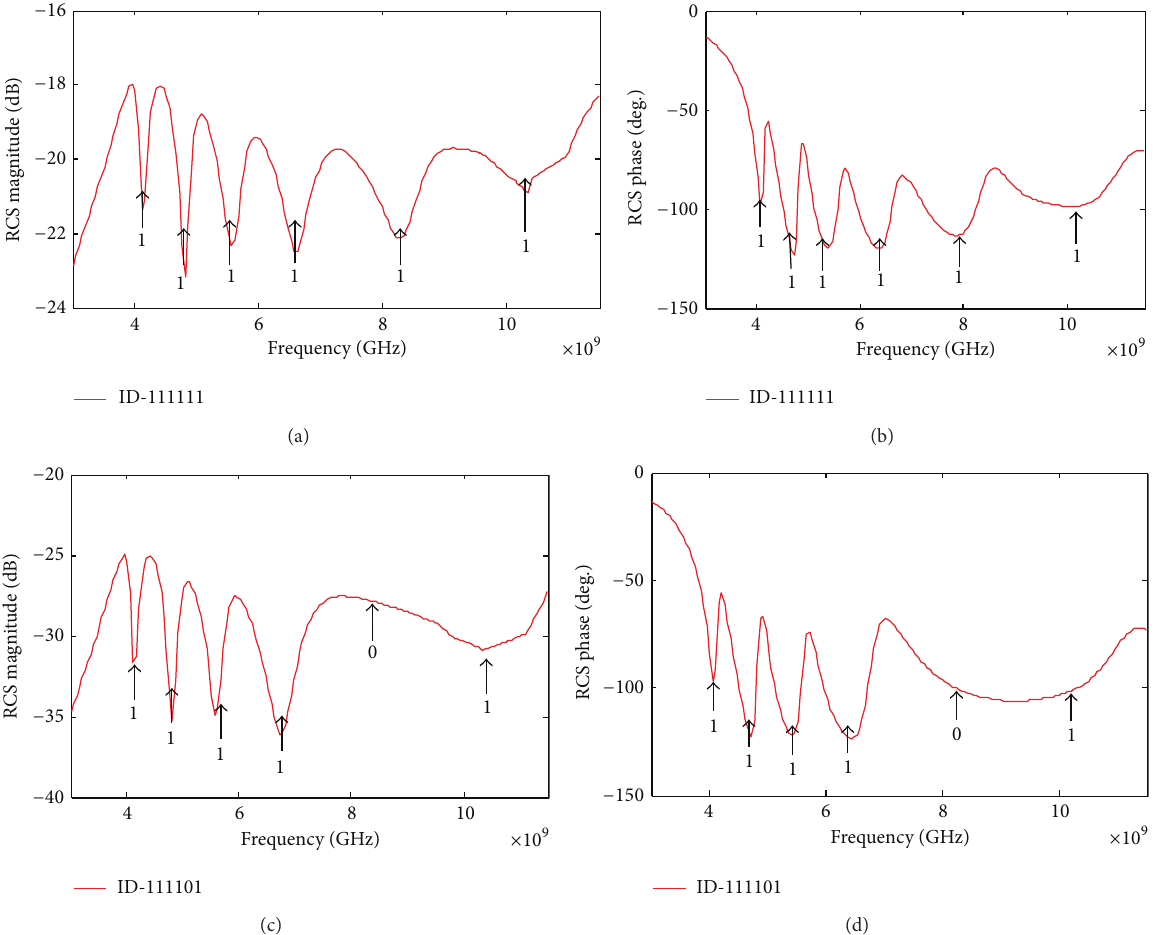
Figure 4: (a) RCS magnitude versus frequency simulation of tag I; (b) RCS phase versus frequency simulation of tag I; (c) RCS magnitude versus frequency simulation of tag II; (d) RCS phase versus frequency simulation of tag